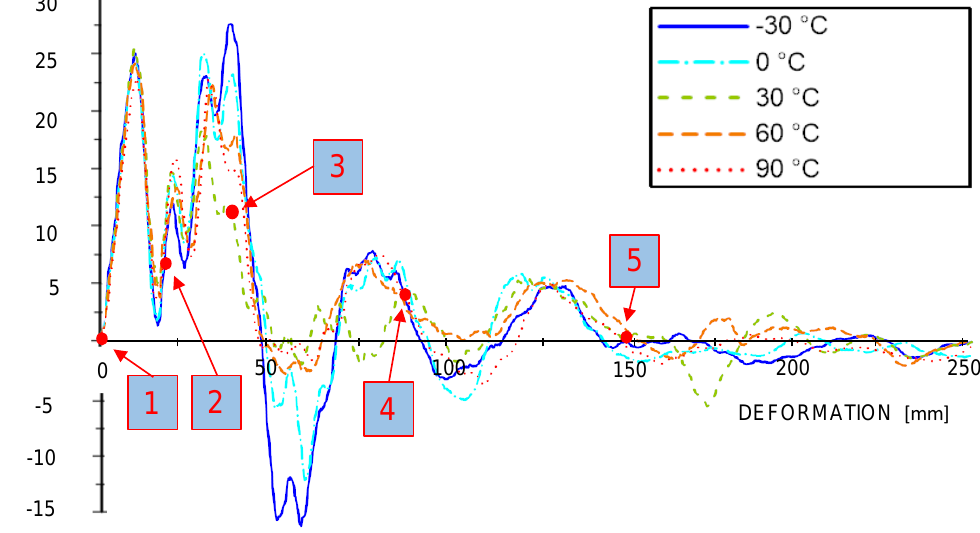
Materials 2020 , 13 , x FOR PEER REVIEW Figure 8. Average force-deformation curves of the dynamic tests. Figure 8. Average force-deformation curves of the dynamic tests.